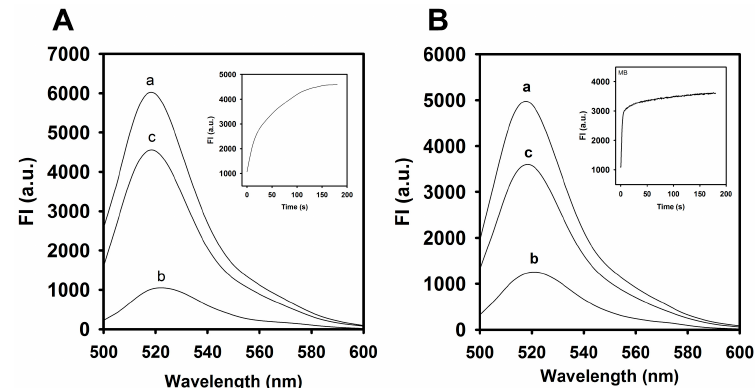
Figure 3. Fluorescence spectra of aptamer and A 12 -MB-A 12 in the absence or presence of CTX3